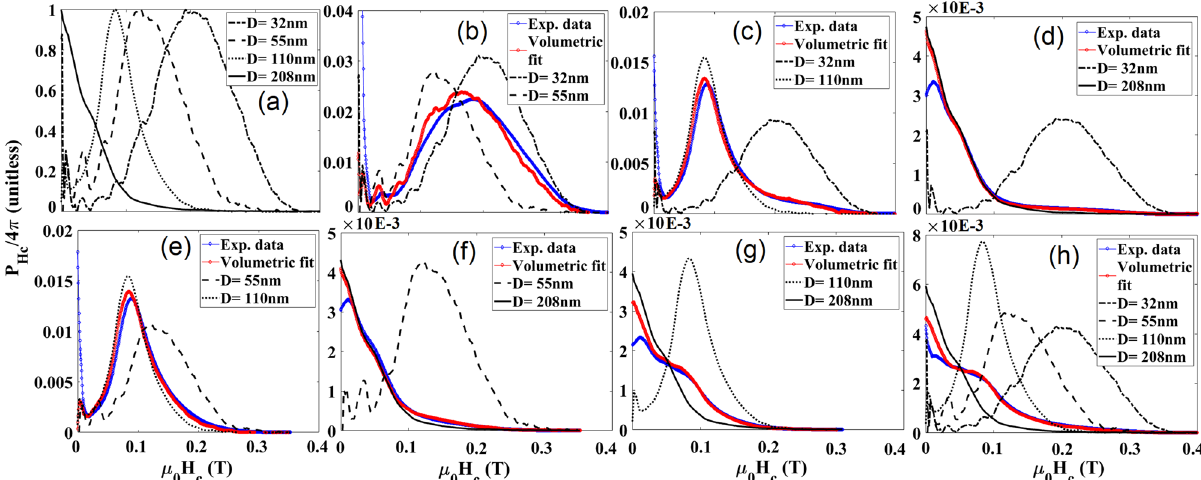
Figure 3. Coercivity distribution (P Hc , determined by taking an integral over H u from FORC heat-maps) for ( a ) normalized for individual types of MNWs, ( b – g ) different combinations of two types of MNWs, as indicated in the legend and ( h ) one combination of four types. The blue lines show measurements of combinations, and the red lines show the best match for combinations of the individual signatures (from a ) using volume ratio, see Table 1.